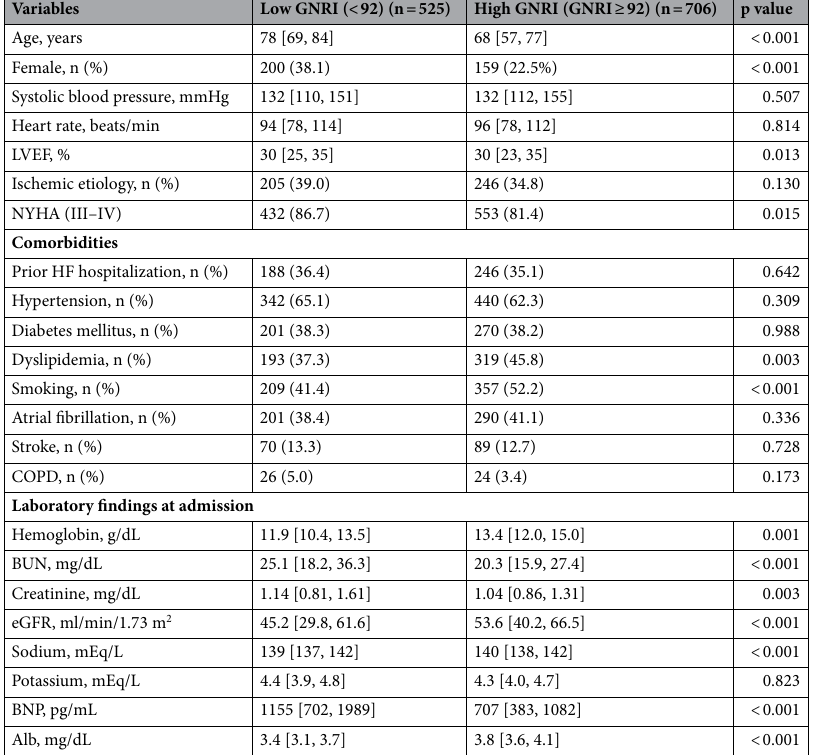
Table 1. Baseline characteristics of patients by nutritional status. Values are median [with interquartile ranges] or n (%). GNRI geriatric nutritional risk index, NYHA New York Heart Association, LVEF left ventricular ejection fraction, HF heart failure, COPD chronic obstructive pulmonary disease, BUN blood urea nitrogen, eGFR estimated glomerular filtration rate, BNP B-type natriuretic